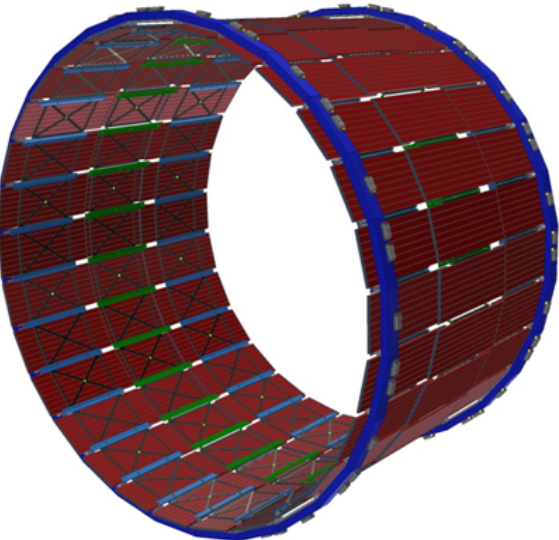
Figure 3. A cylindrical detector constructed of 84 MCORD